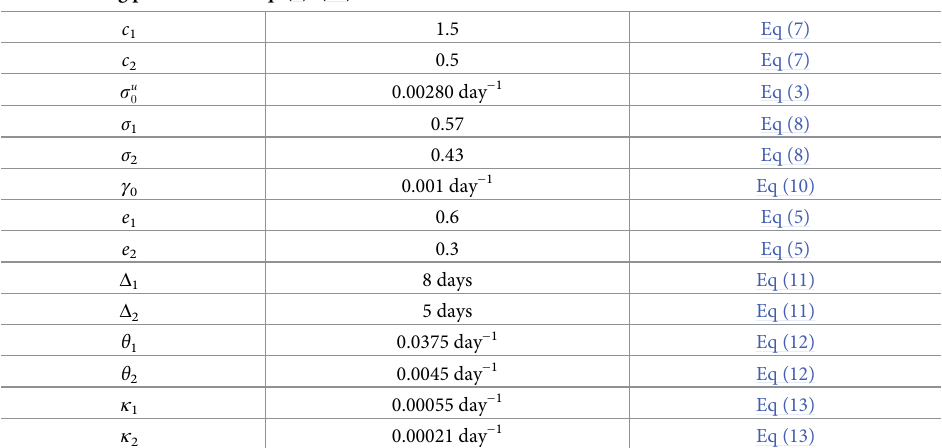
Table 3. Fitting parameters in Eqs (7)–(13).